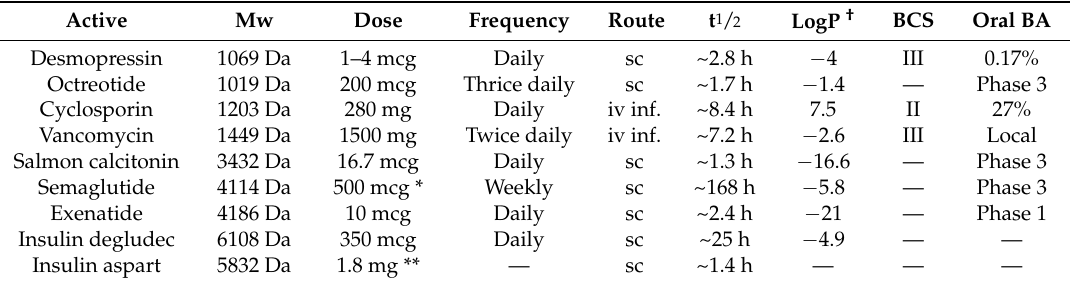
Table 1. Properties of selected approved peptides and their routes of delivery (source of information: Health Products Regulatory Authority (HPRA) summary of product characteristics (SPC), Drugbank, PubChem, and Welcome Compound Report